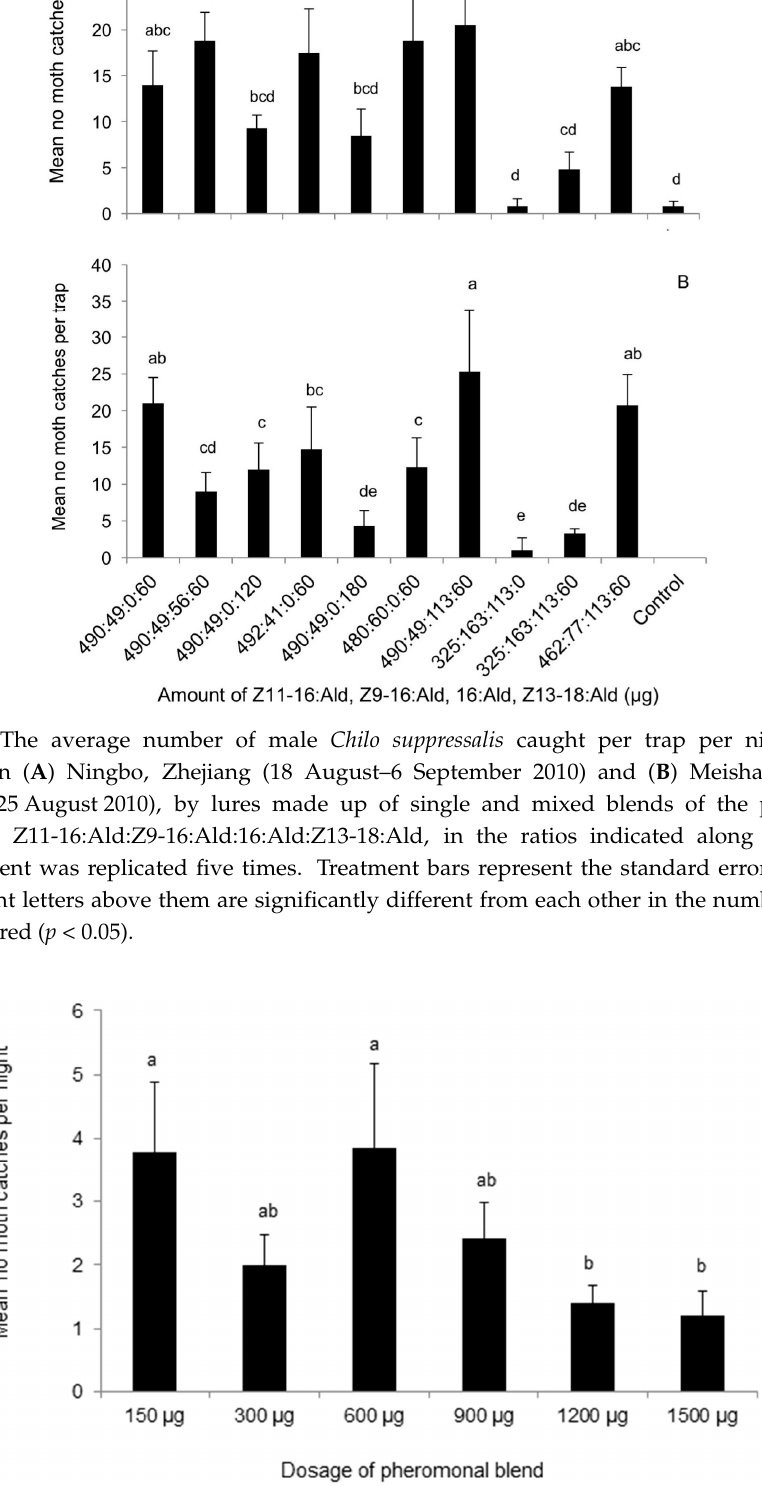
Figure 4. Dose-response of Chilo suppressalis to synthetic pheromone blends in Ningbo, Zhejiang (5 May–21 May 2010). The treatment bars represent the standard errors; the bars with different letters above them are significantly different from each other in the number of male moths captured ( p < 0.05). The blend ratio of Z11-16:Ald:Z9-16:Ald: Z13-18:Ald was 490:49:60 in all lures.